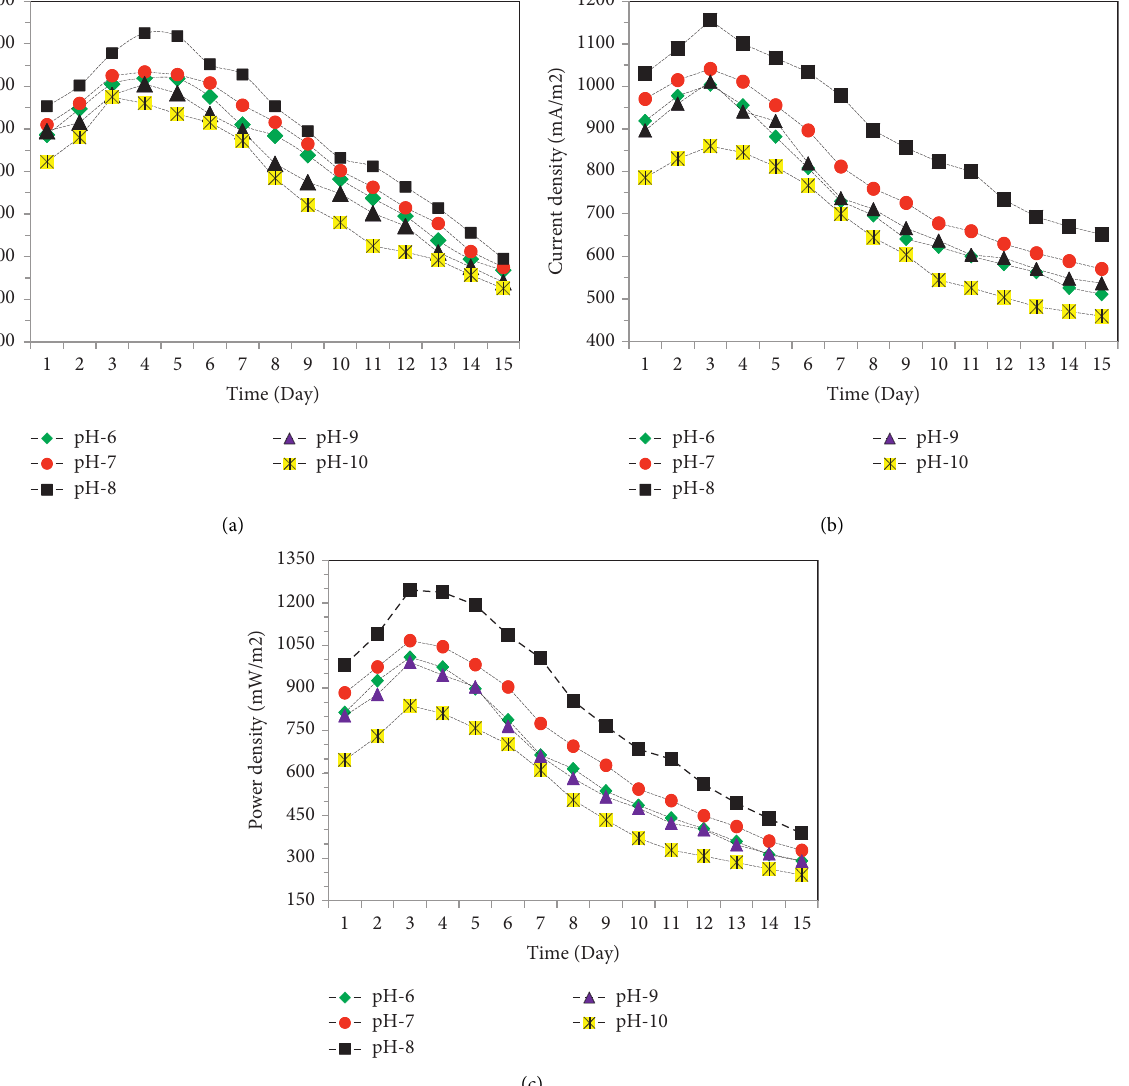
Figure 3: Effect of pH on the (a) generated voltage, (b) current density, and (c) power density by using municipal